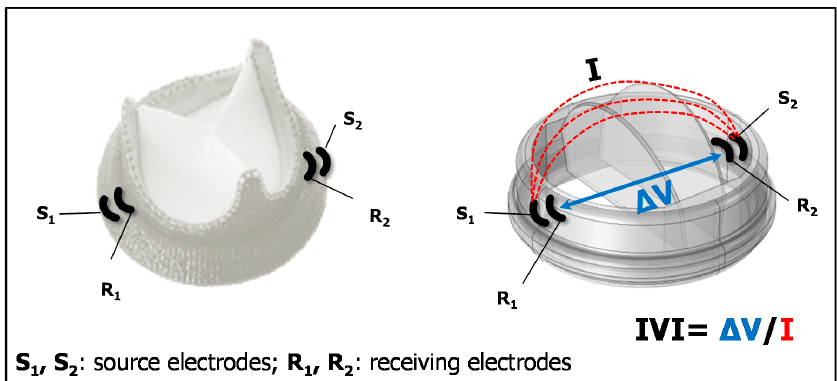
Figure 1. The principle of measurement of IntraValvular Impedance (IVI): Current pulses (I) are injected via source electrodes (S1, S2) to generate local electric field interfering with leaflet movement, and voltage ( ∆ V) is recorded between receiving electrodes (R1, R2).